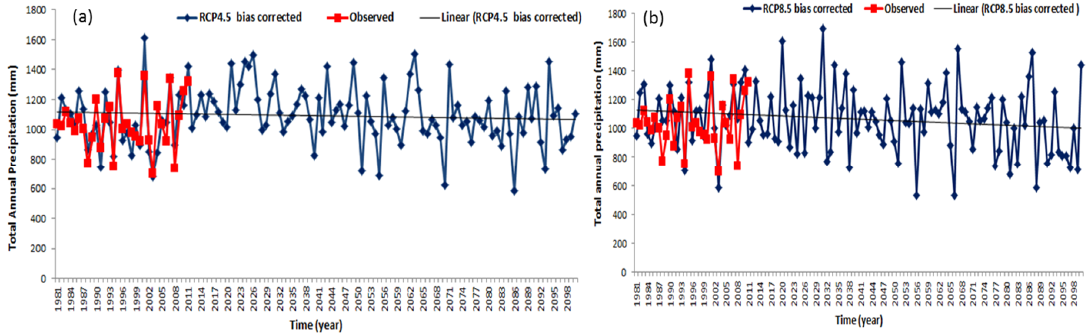
Figure 6. Future trends of ( a ) RCP4.5 and ( b ) RCP8.5 total mean annual rainfall (1981–2100).